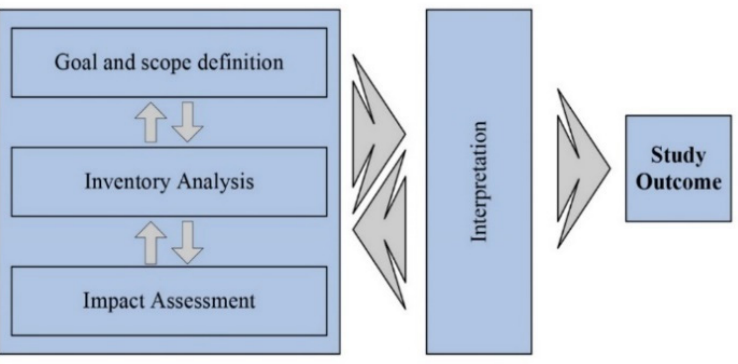
Figure 6. Life-cycle assessment framework [40–43].